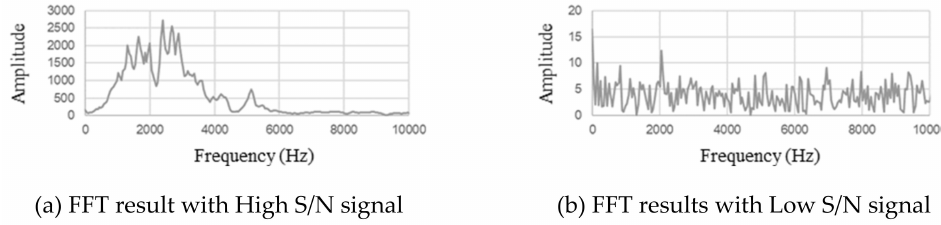
Figure 6. An example of FFT (Fast Fourier Transform) result of low S / N signal.